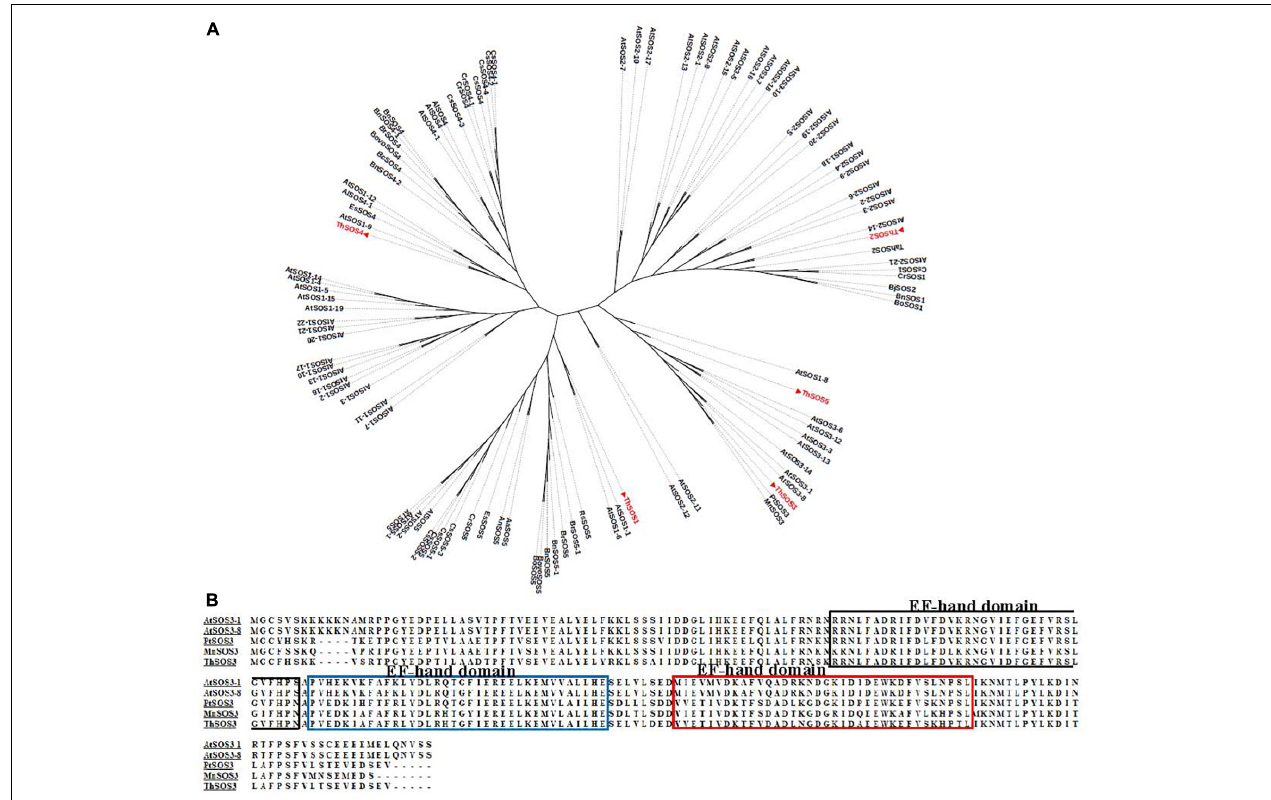
FIGURE 1 | Phylogenetic and sequence analysis of ThSOS proteins. (A) Phylogenetic analysis of ThSOSs and other SOS proteins from different plant species. (B) Alignment of the ThSOS3 protein sequence with other plant SOS3 protein sequences. The sequences of SOS proteins were downloaded from the GenBank database, and their GenBank accession numbers are listed in Supplementary Table S1